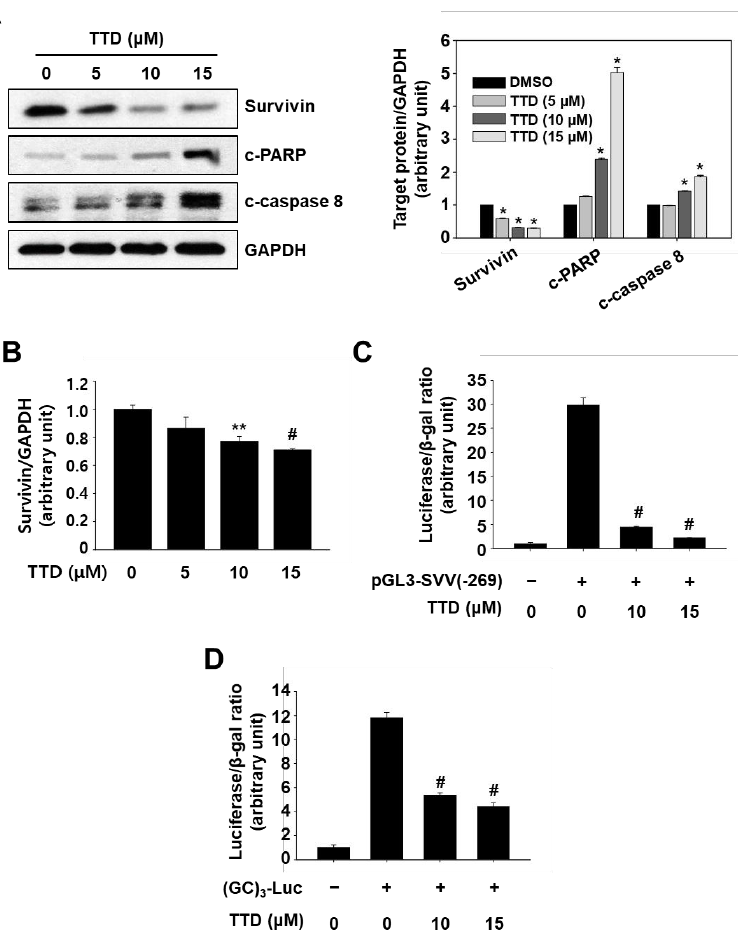
Figure 4. TTD inhibits Sp1-mediated survivin expression and induces apoptosis in pancreatic cancer cells. ( A ) Panc-1 cells were treated with various concentrations of TTD for 24 h, and whole-cell lysates were analyzed by western blot analysis. GAPDH was used as a loading control. The molecular weight of c-PARP and c-caspase 8 is 89 kDa and 41/43 kDa, respectively. ( B ) Cells were treated with TTD for 18 h, and the survivin mRNA level was determined by real-time PCR as described in the Materials and Methods section. ( C ) Cells were transfected with 25 ng of pGL3-SVV (-269) ( C ) or 25 ng of pGL3-(GC) 3 -Luc ( D ) for 5 h and then treated with TTD for 18 h. Luciferase activity (relative to β -galactosidase) was determined, and the corresponding empty vector was used as a control. The results are presented as means ± SEM ( n ≥ 3 replicates). * p < 0.05, ** p < 0.01, and # p < 0.001 vs. DMSO.